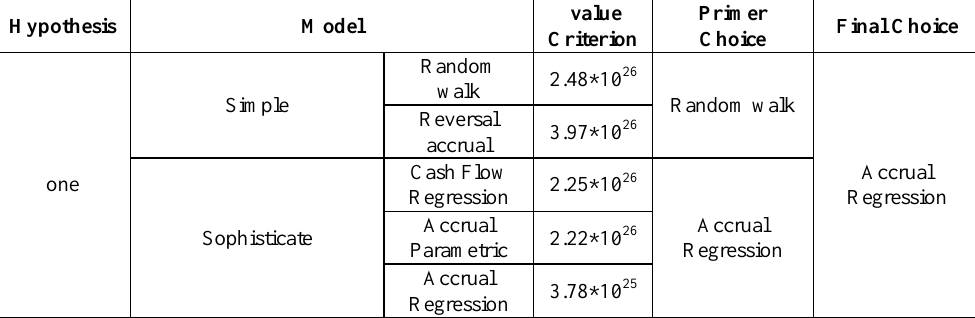
Table 11. Choosing a proper model based on the sum of squared prediction errors Hypothesis